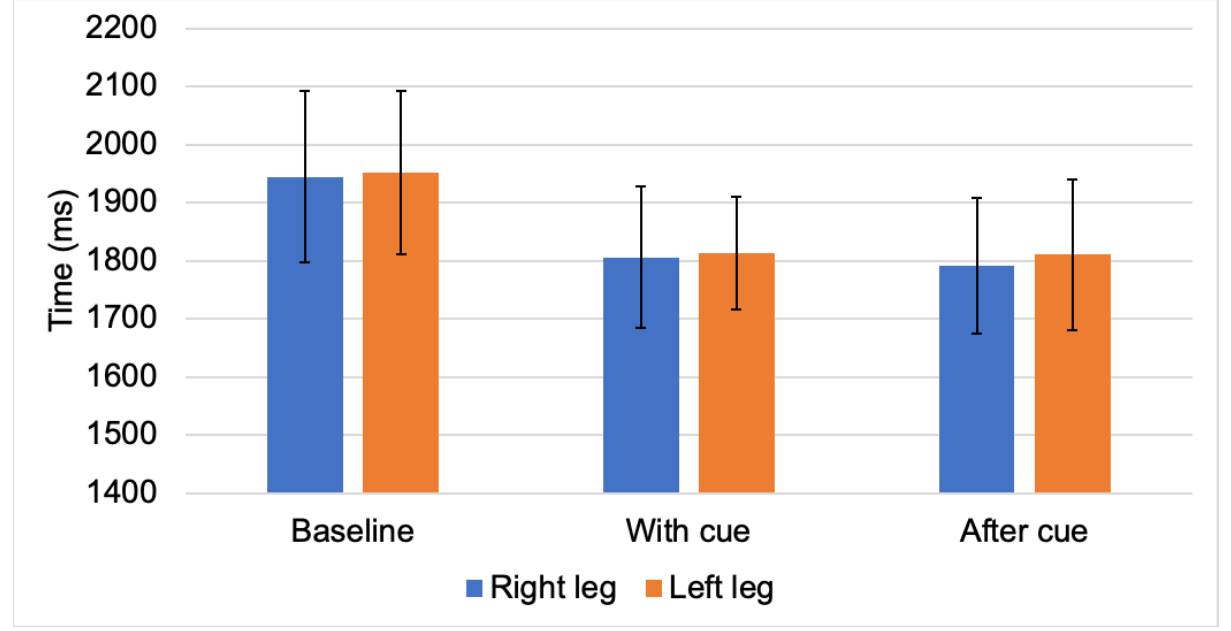
Figure 3. Temporal gait parameters (stride cycle time) for both legs in the baseline, with-cue, and after-cue